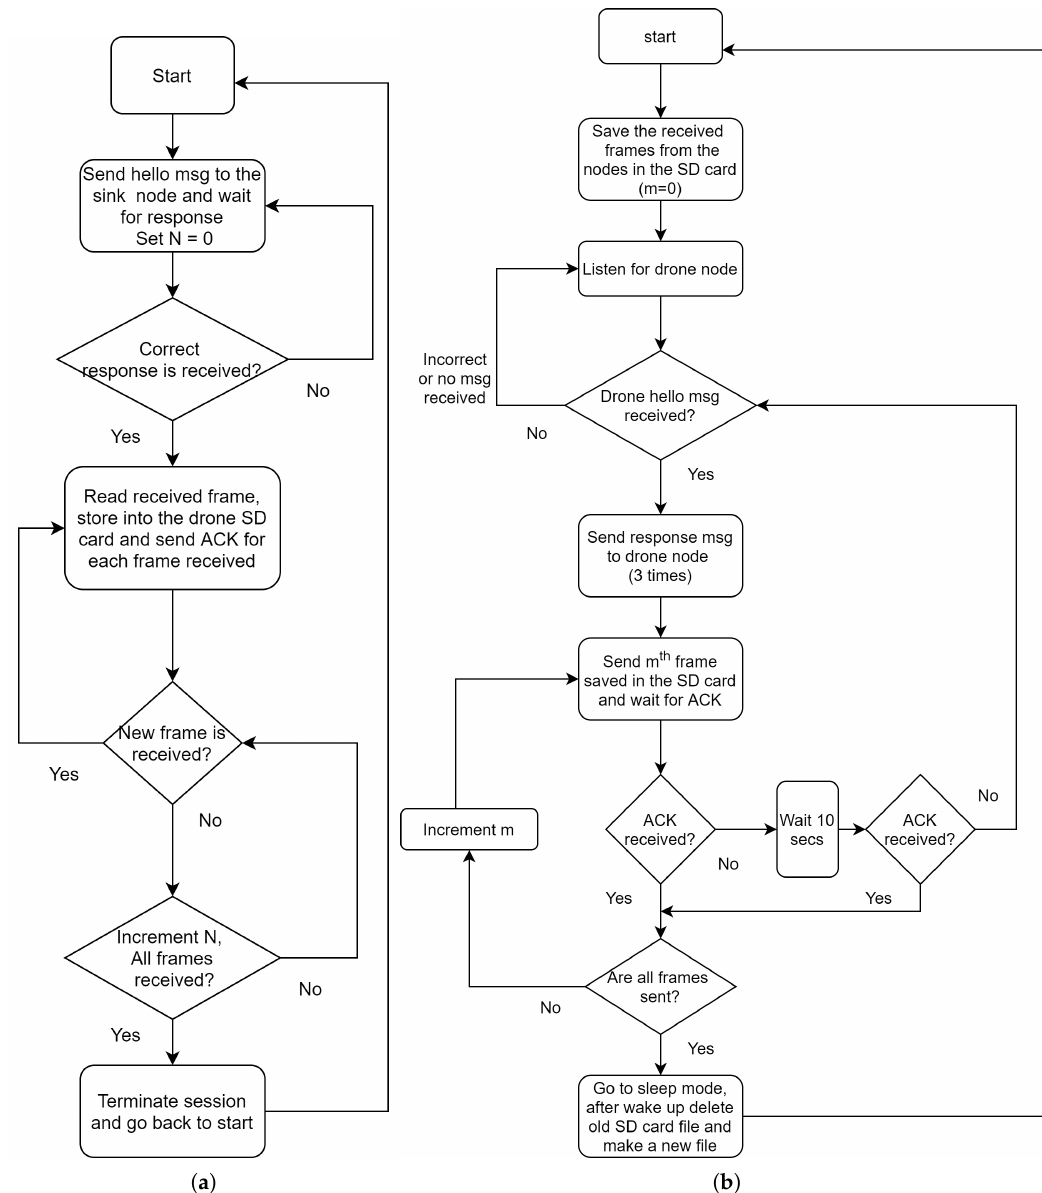
Figure 11. A flow diagram for the ( a ) UAV, and ( b ) sink nodes during the handshaking and data transmission processes. A code implementation of the proposed protocol is published and can be found in this URL